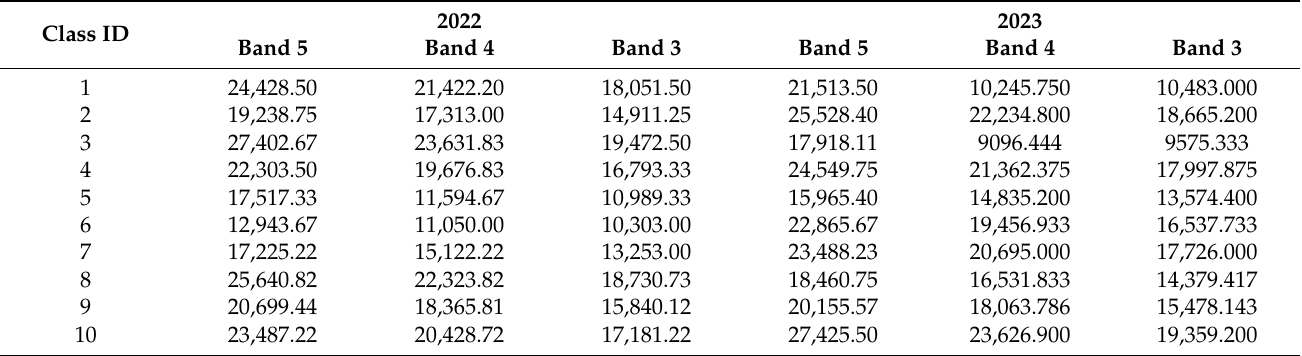
Table 5. Pairwise comparison of the k-means classification for Bands 5-4-3 of the Landsat-8 OLI/TIRS images for 2022 and 2023 in Qena Bend region 1